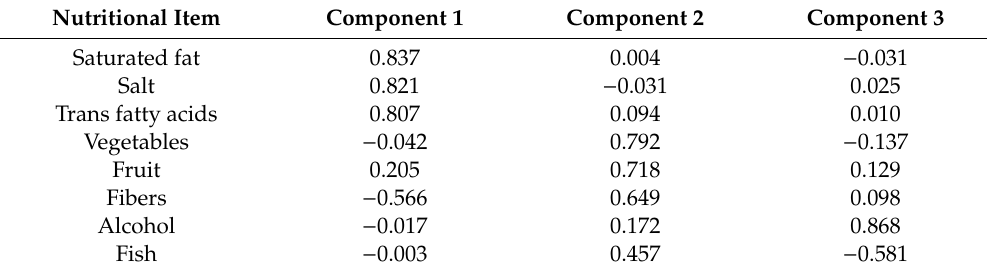
Table 2. PCA components: Factor